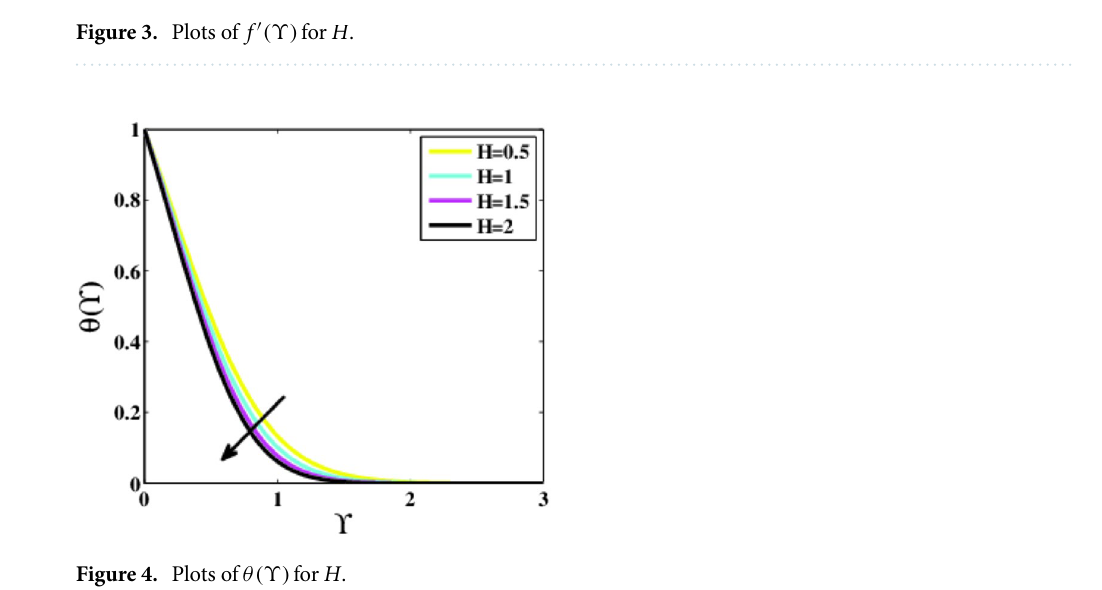
Figure 4. Plots of θ(ϒ) for H .